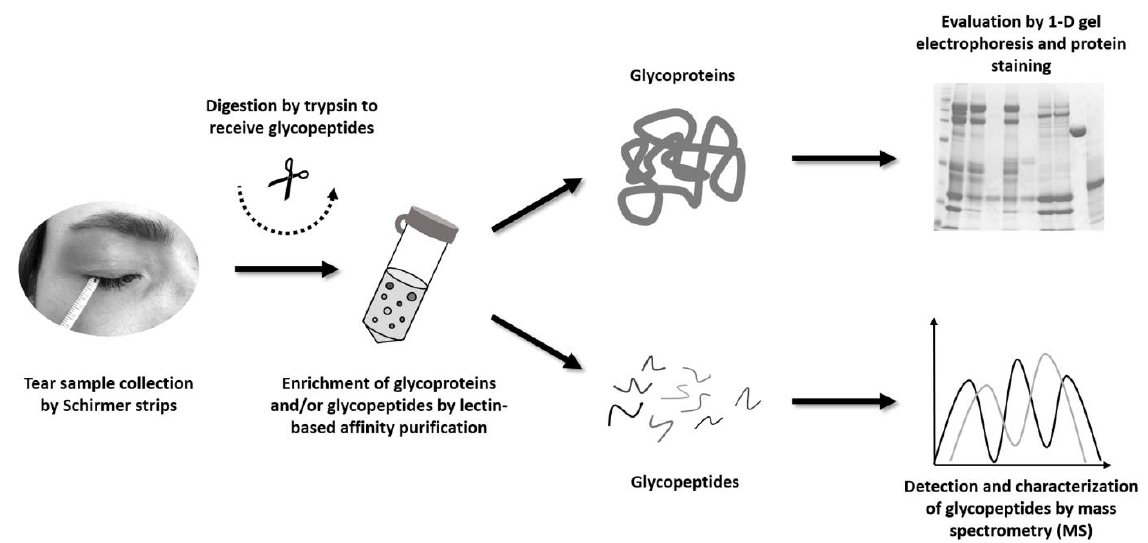
Figure 1. Schematic illustration of the sample preparation protocol used for the affinity enrichment of glycoproteins/glycopeptides from human tear sample pools. The tear samples from healthy individuals were collected by Schirmer’s strips and the tear proteins were subsequently eluted with 300 µ L of PBS. Then, the individual tear protein samples were pooled according to the specifications in the method Section 4.3. The enrichment of the glycoproteins and/or glycopeptides was based on lectin affinity chromatography. The enrichment performance of various single-lectin and multi-lectin columns was evaluated first on the native glycoprotein level by 1D gel electrophoresis and specific protein stainings (glycoprotein and Coomassie staining). Next, the established and optimized lectin affinity method was employed for the enrichment of glycopeptides from human tear sample digests. Then, the enriched and concentrated glycopeptides and their characteristic N-glycosylation sites were identified by high-resolution MS.